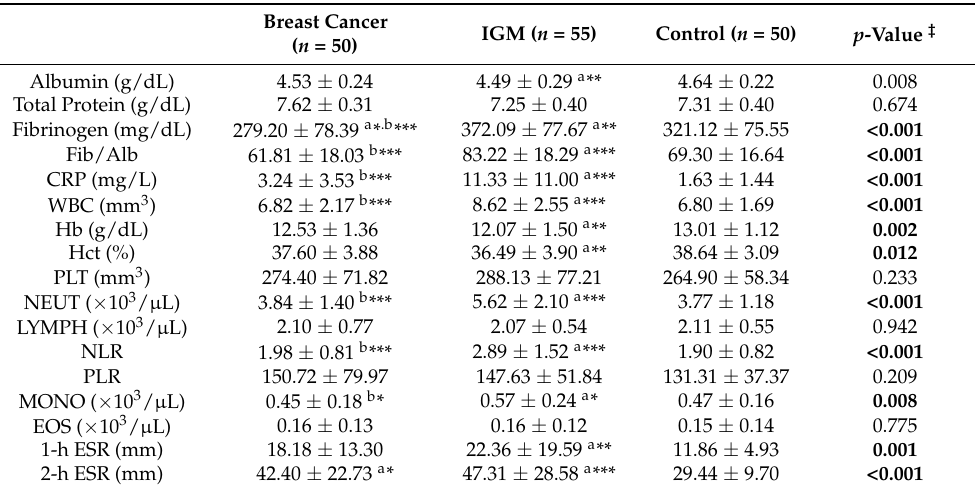
Table 3. Biochemical laboratory findings and hematological indexes of breast cancer, IGM and control groups.